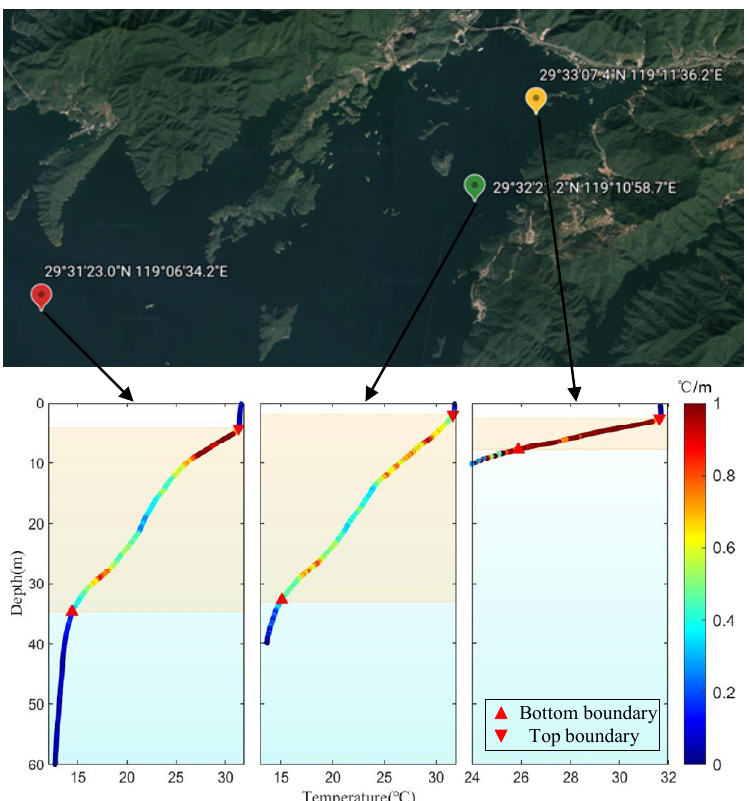
Figure 9. Thermocline measurements at three different locations in Qiandao Island Lake using floats. Table 2. Thermocline properties.